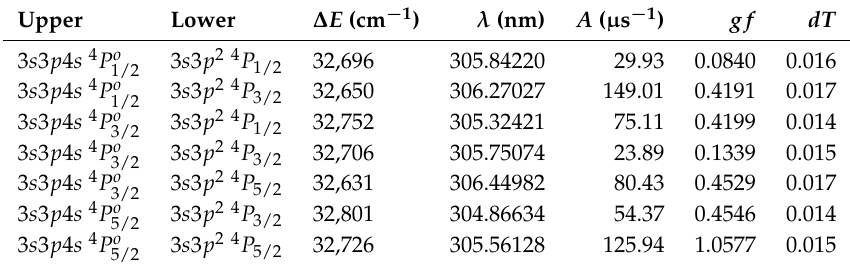
Table 3. Ab initio electric dipole (E1) transition data for the 3 s 3 p 2 4 P to 3 s 3 p 4 s 4 P o transition computed in the length form from valence correlation results.